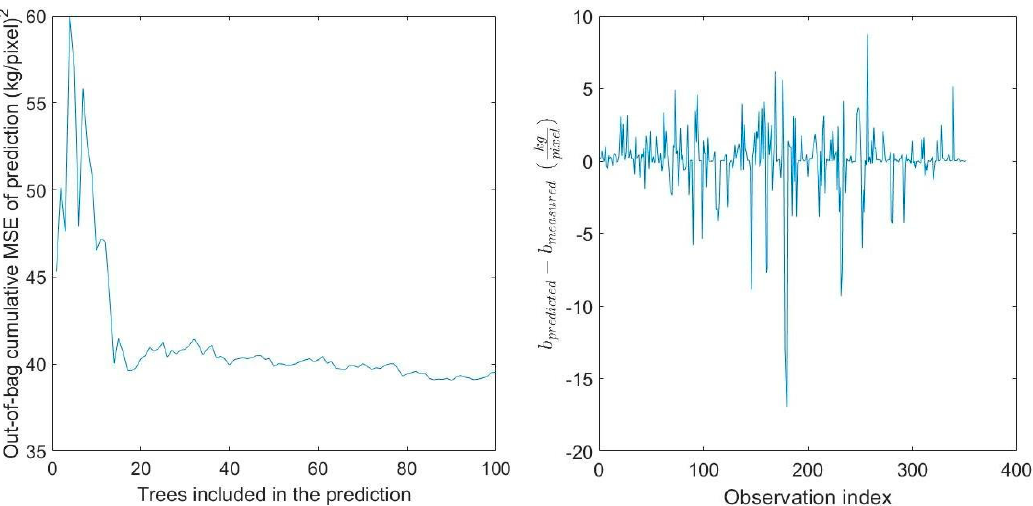
Figure 6. Cumulative mean squared prediction error for the out-of-bag biomass density values of the training dataset for the Landsat-8-trained regression tree ensemble. Error of prediction on the training dataset observations for the Landsat-8-trained regression tree ensemble.